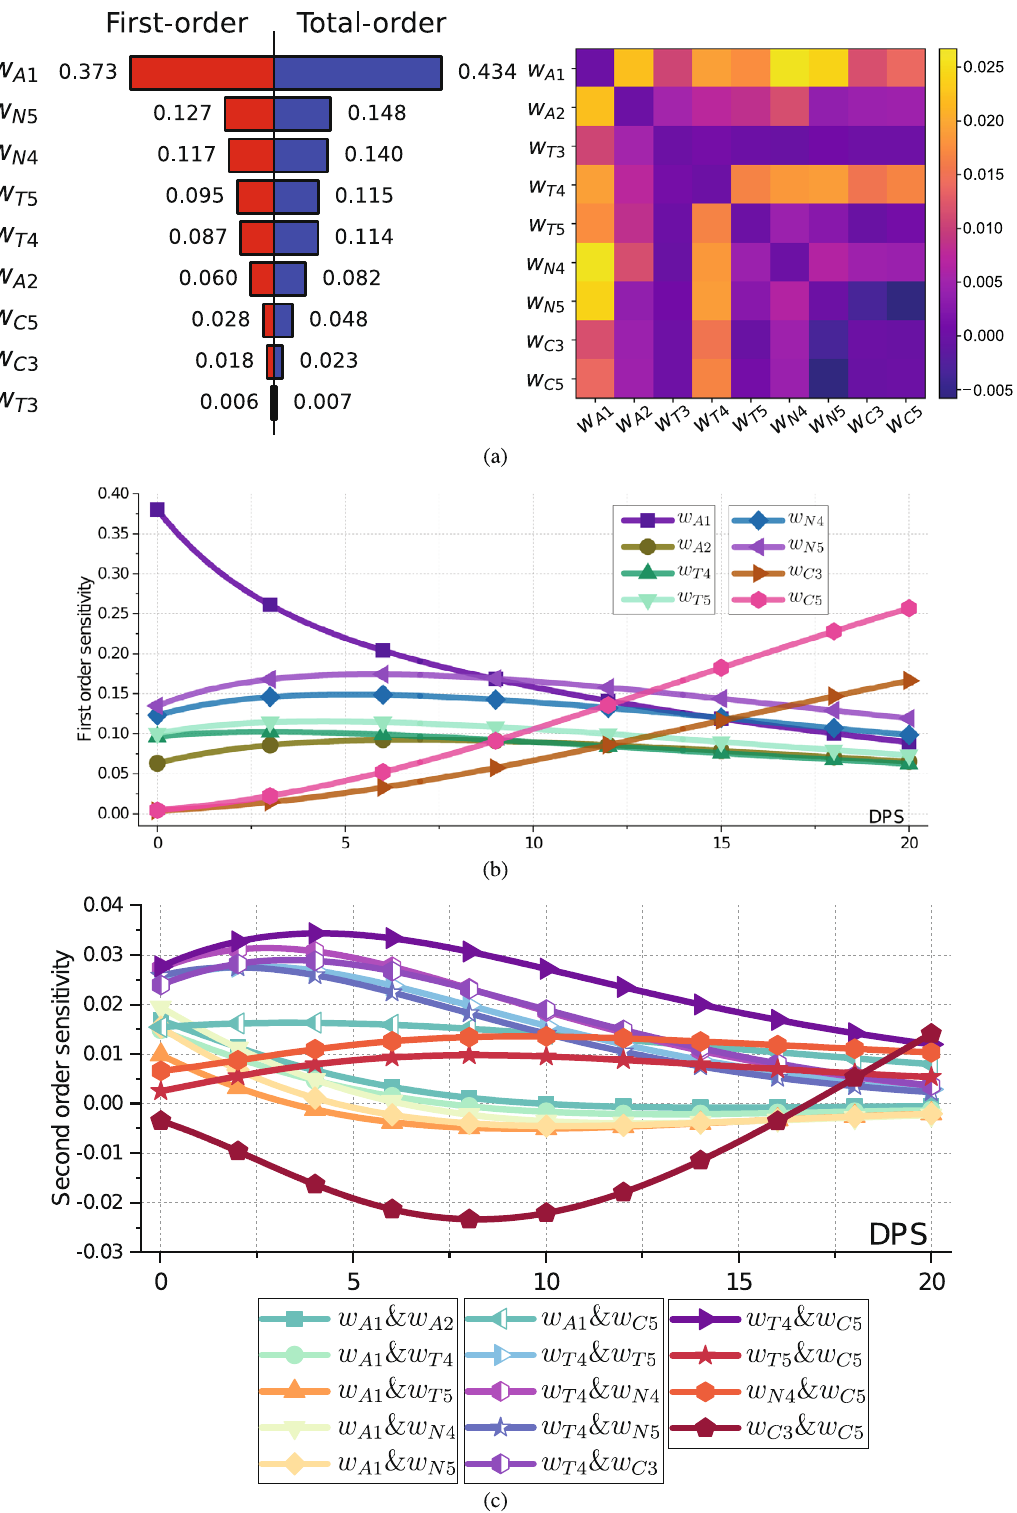
Fig. 3 The Sobol sensitivity analysis plots with respect to cognitive decline. a First-order, second-order, and total-order Sobol sensitivities of C (0). Left: the red rectangles are assigned fi rst-order sensitivities of model parameters, and the blue rectangles are their total-order sensitivities. The length of the rectangles represents the attribution of sensitivities to outputs; Right: each square represents the second-order sensitivity correlations of two model parameters. The lighter the color, the stronger the positive correlation while the darker the color, the stronger the negative correlation. b The dynamics of fi rst-order Sobol sensitivities with respect to DPS. Each curve corresponds to the fi rst-order sensitivity values with an output C ( s ). Only fi rst-order sensitivity values greater than 0.01 are plotted. c The dynamics of second-order Sobol sensitivities for two parameters with respect to DPS. Only the maximum absolute second-order sensitivity values greater than 0.01 are